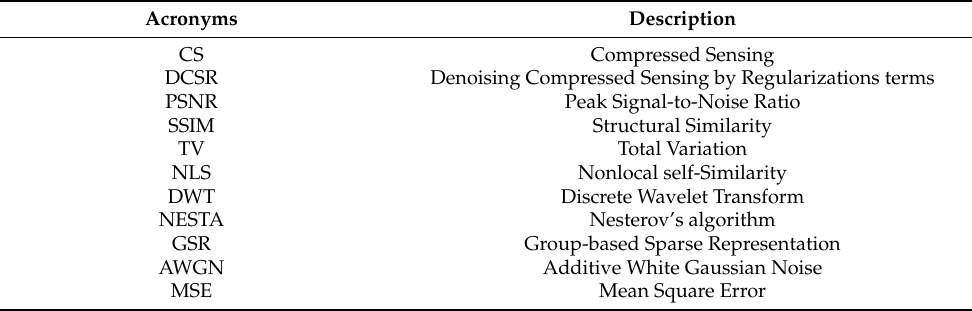
Table 4. Definition of